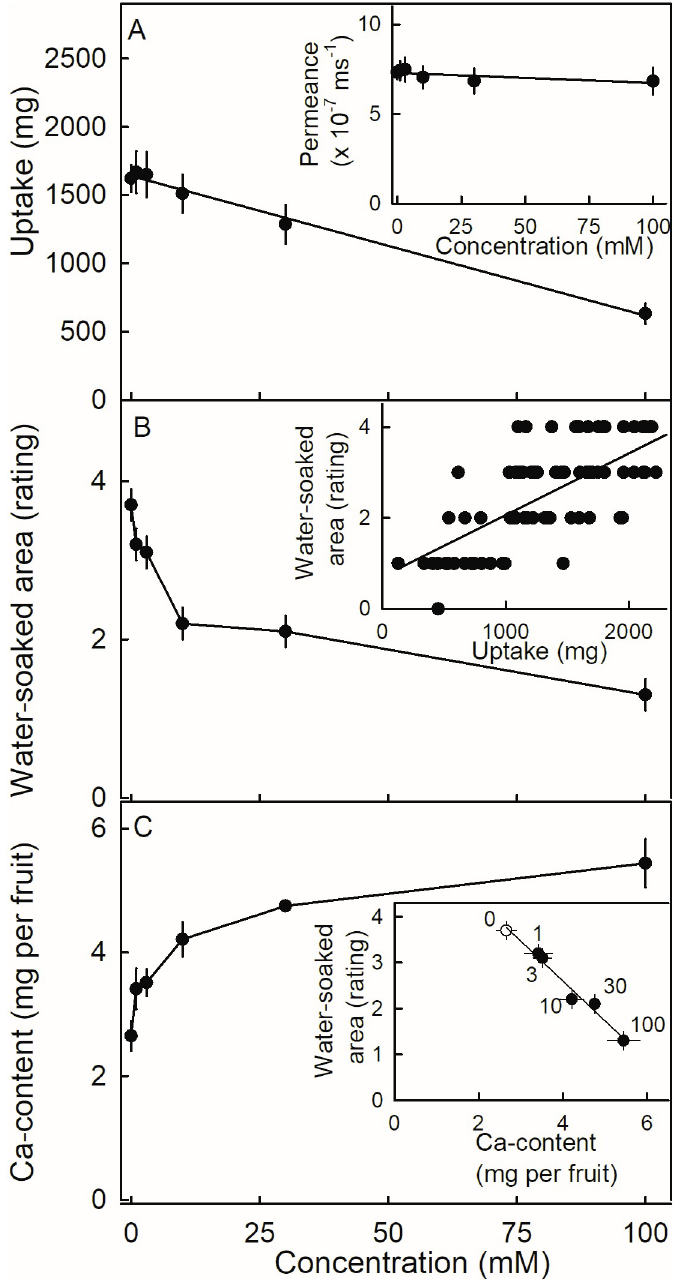
Fig 3. Effect of the concentration of CaCl 2 on (A) water uptake, (B) water soaking, and (C) Ca content of ‘Clery’ strawberry. Inset in (A): Relationship between permeance and CaCl 2 concentration. Inset in (B): Relationship between water soaking and water uptake. Inset in (C): Relationship between water soaking and fruit Ca content. The numbers on the graphs represent the corresponding CaCl 2 concentration (mM). solubilization [6, 12]. Similar effects on crosslinking have been reported for FeCl of sweet cherry fruit [13]. The effect of Ca on crosslinking of cell walls in strawberry was statis- tically significant, but not very large. In the presence of Ca, the amount of water uptake toler- ated without bursting of cells and leakage of anthocyanins was higher compared to the amount